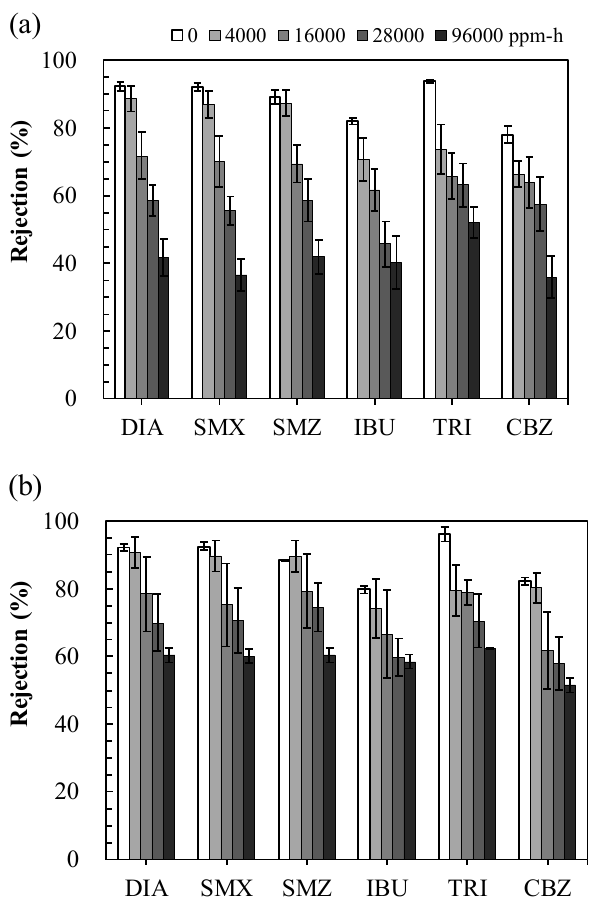
Figure 7. The removal of PPCP by ( a ) TFC and ( b ) TFC-GO membranes with the range of 0 − 28,000 ppm-h H 2 O 2 exposure. Error bars represent one standard deviation of triplicate measurements.